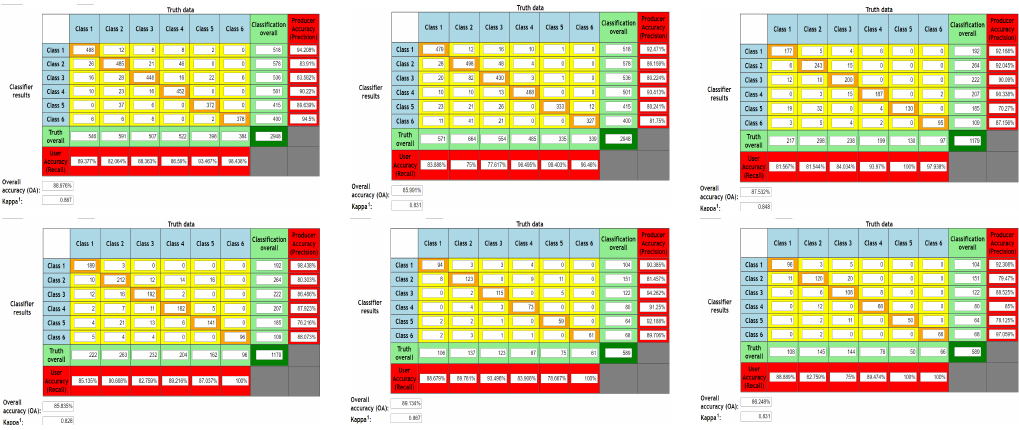
Figure 18. Confusion matrix for 2-fold, 5-fold and 10-fold cross validation for LSTM and VAE-CNN, respectively.